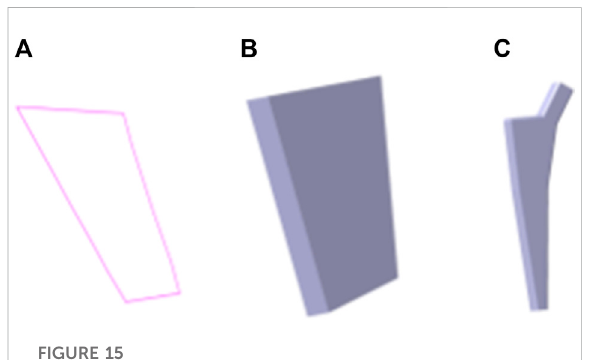
FIGURE 15 Femoral stem prosthesis generation based on bionic vein structure. (A) Feature sketch No.7 in Figure 14B. (B) Entity model is generated by fi lling the feature sketch in panel A to generate surface, and then stretching the surface. (C) Clover bone plate is generated based on the entity model shown in panel (B) .